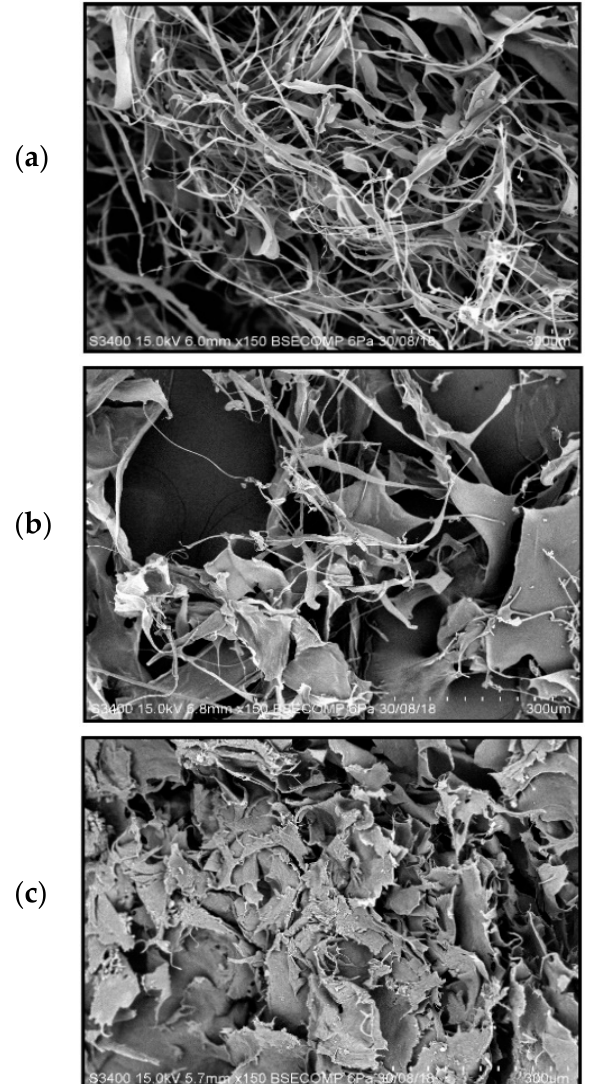
Figure 3. SEM images of collagen ( a ) standard Collagen (calf skin), ( b ) D-PSC, and ( c )